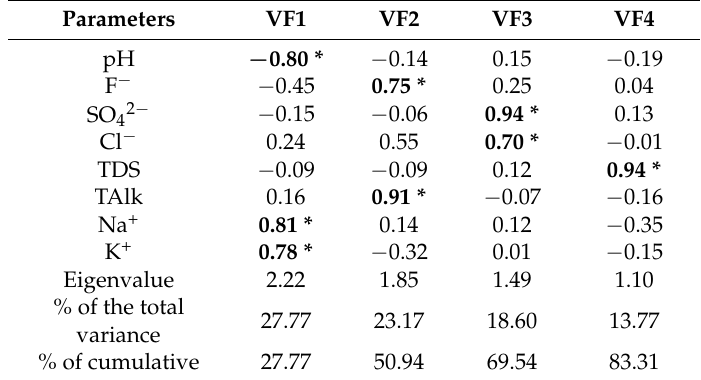
Table 4. Varimax rotated R-mode factor loadings on all the parameters